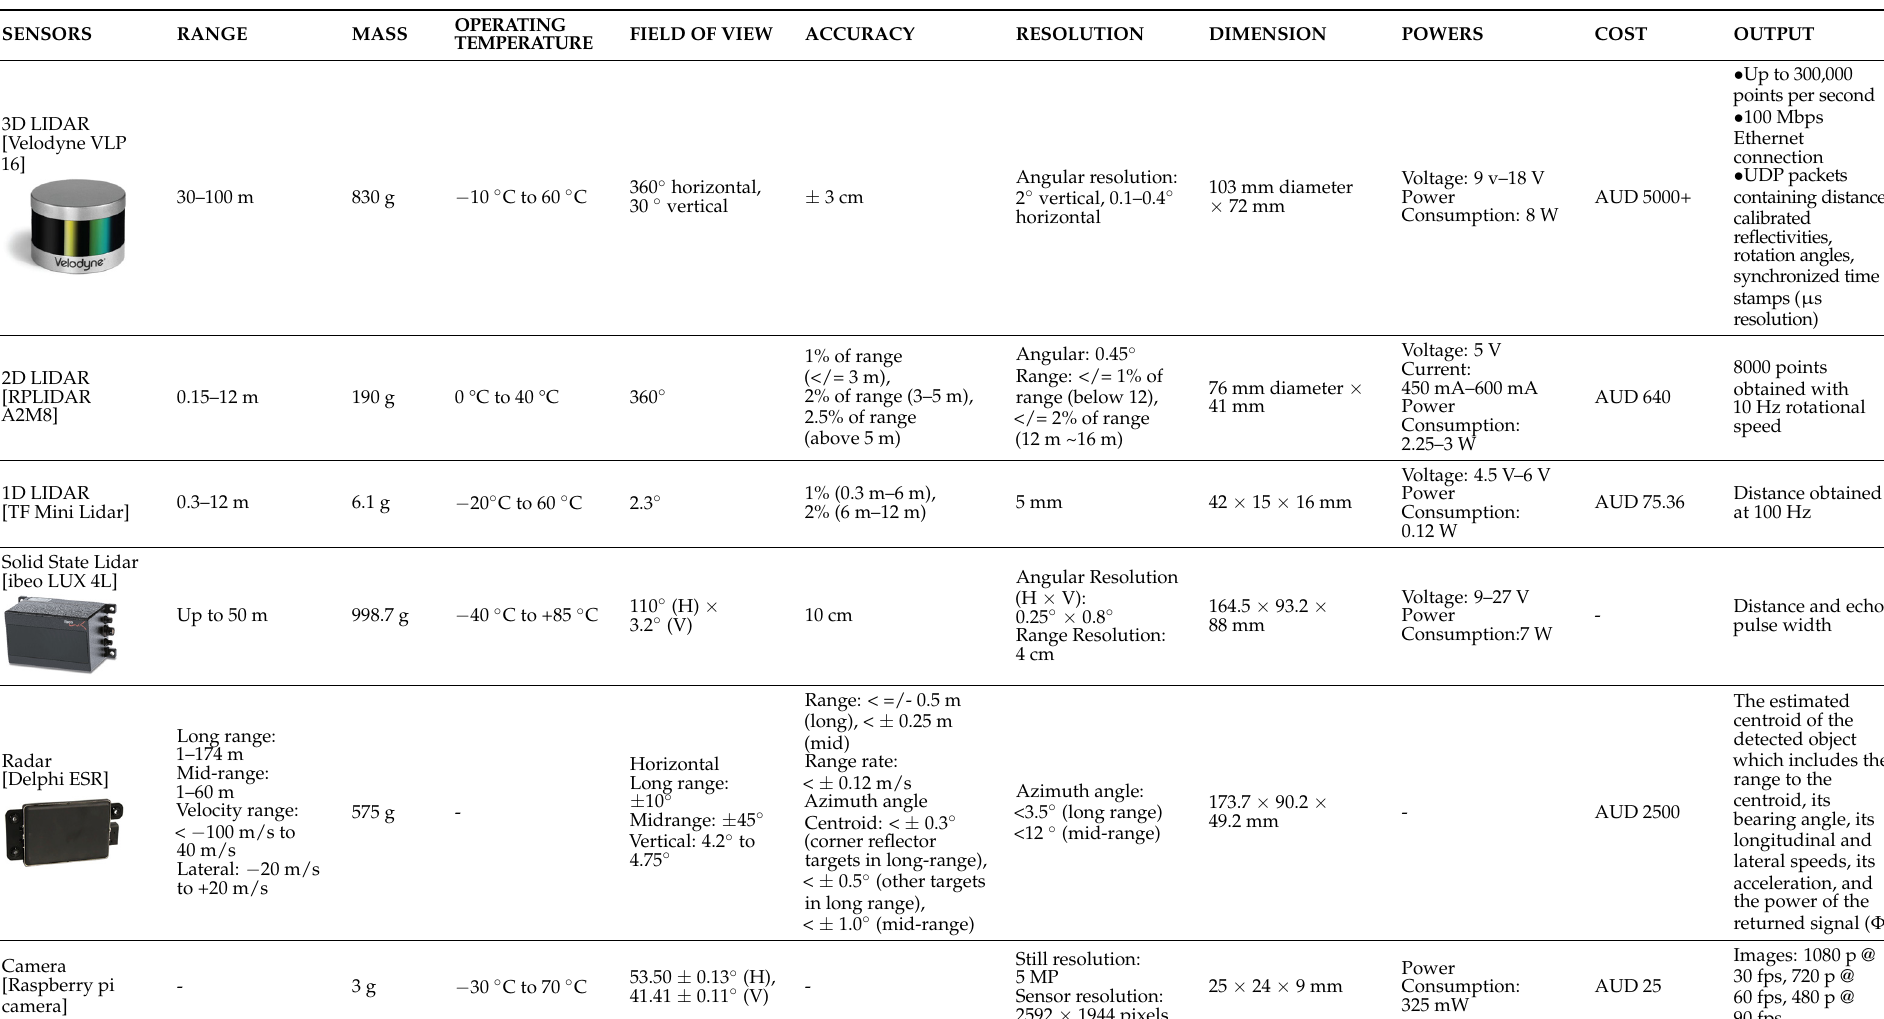
Table 3. A Summary Table of Obstacle Detection Sensor Features [Lidar: [10,50,58–61], Radar: [62,63], Camera: [64–67], Ultrasound: [68], Infrared: [69].